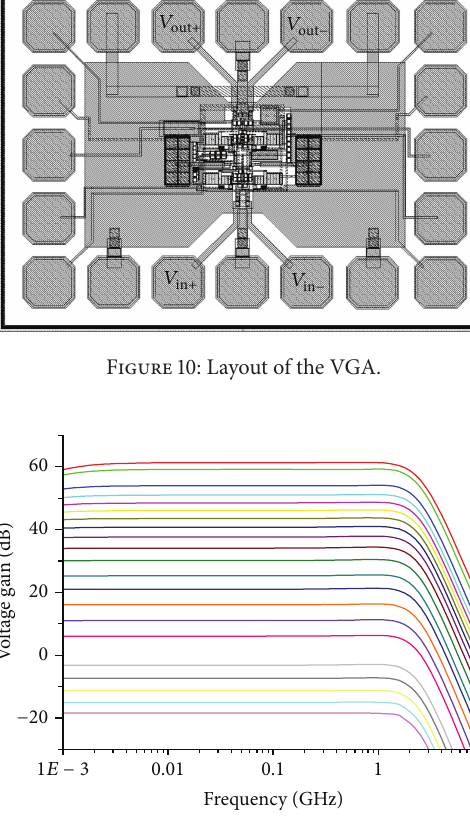
Figure 11: Frequency response versus various control voltage 𝑉 𝑝